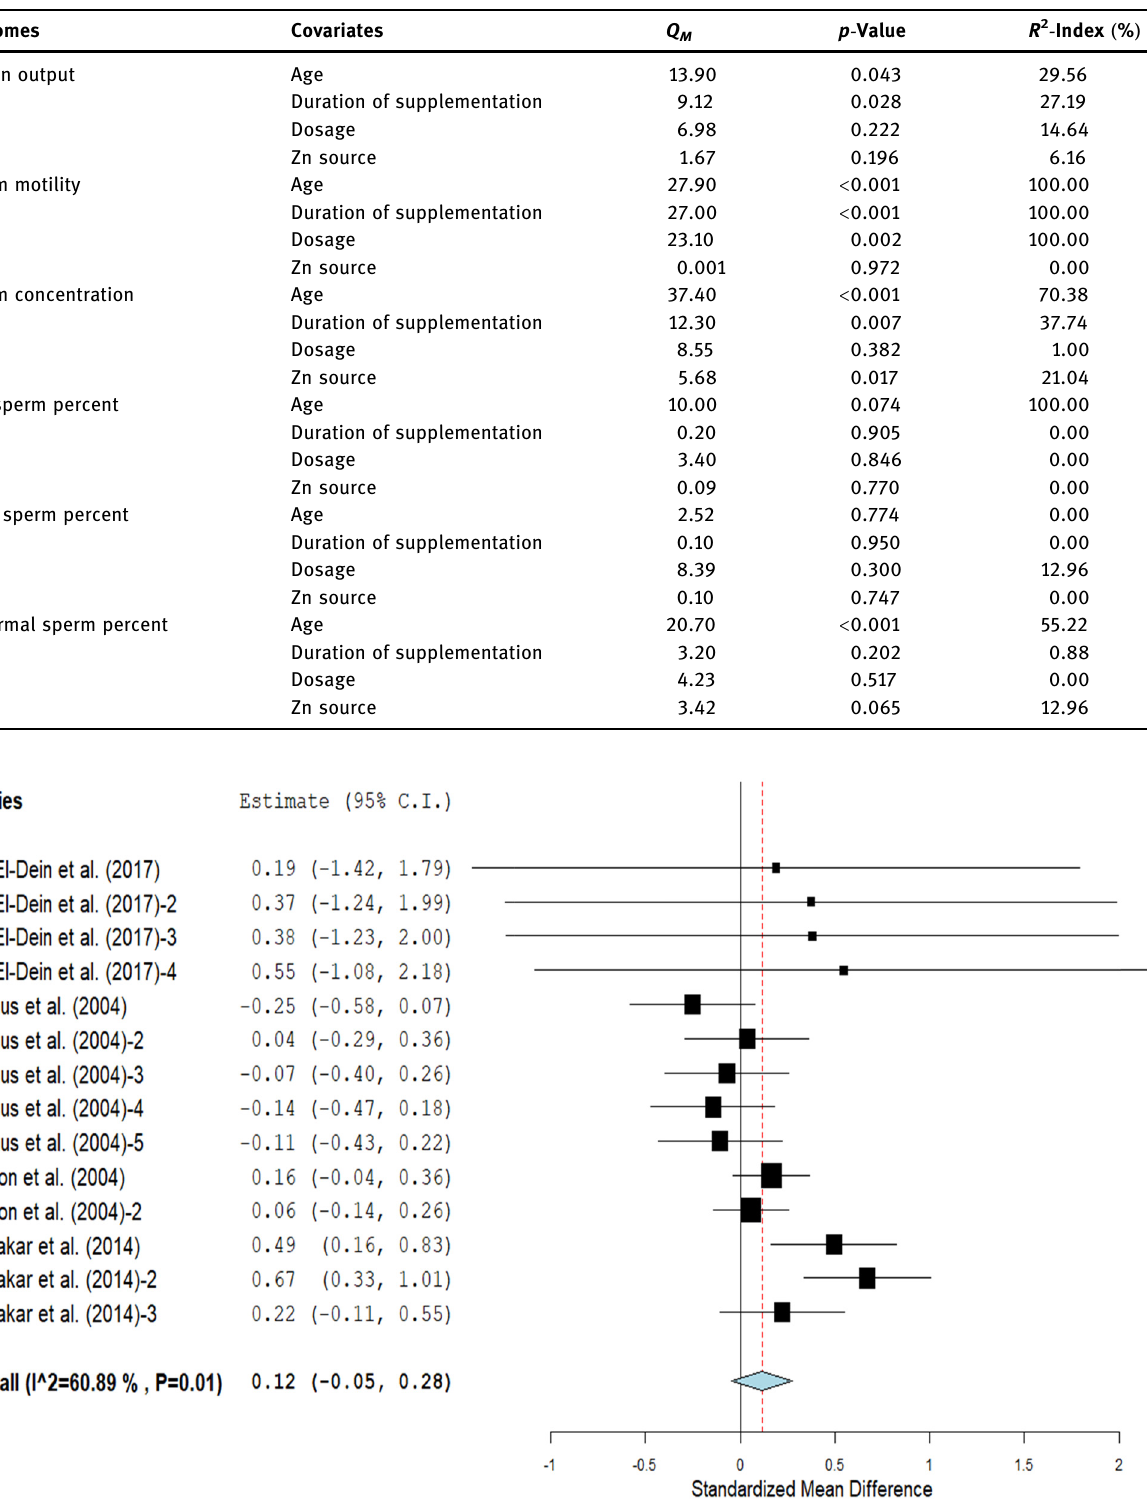
Table 3: Results of a simple meta - regression of outcome measures versus covariates